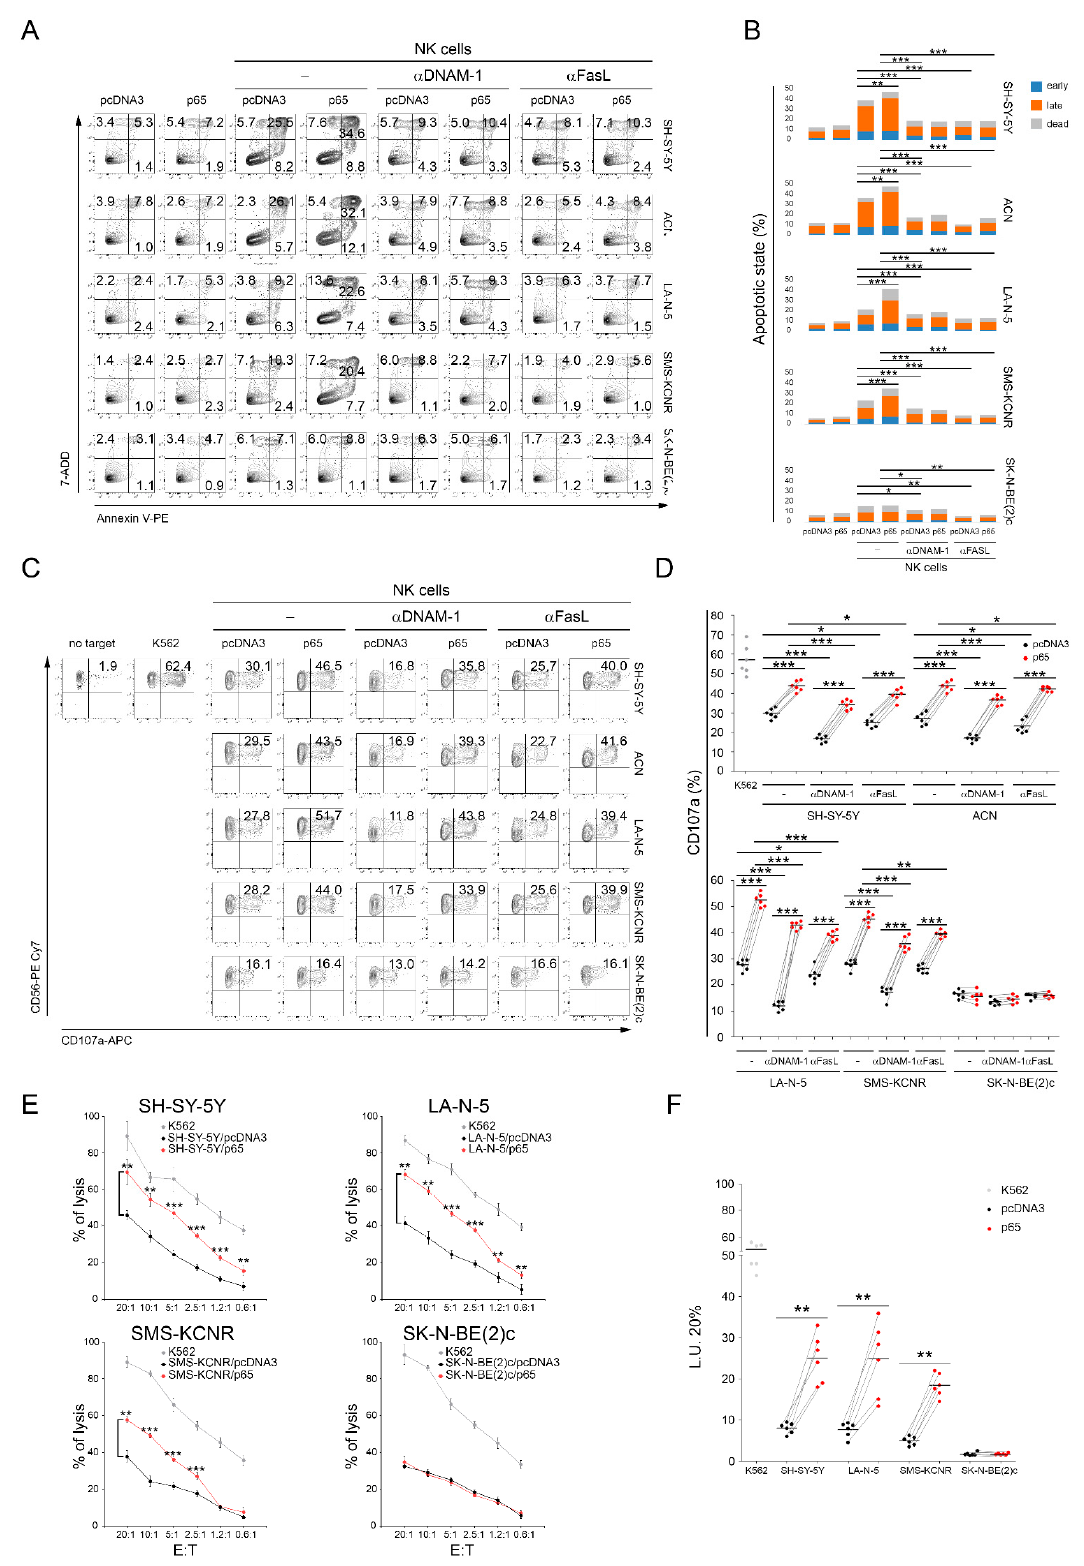
Figure 2. Transfection of the NF-kB p65 subunit renders NB cell lines more susceptible to NK-cell-mediated apoptosis, recognition, and killing. ( A ) NB cell lines, transiently transfected for 48 h with either an pcDNA3 empty vector or the vector expressing the p65 subunit, were co-cultured for 4 h with untreated ( − ) or anti-DNAM-1 or anti FasL-treated NK cells,